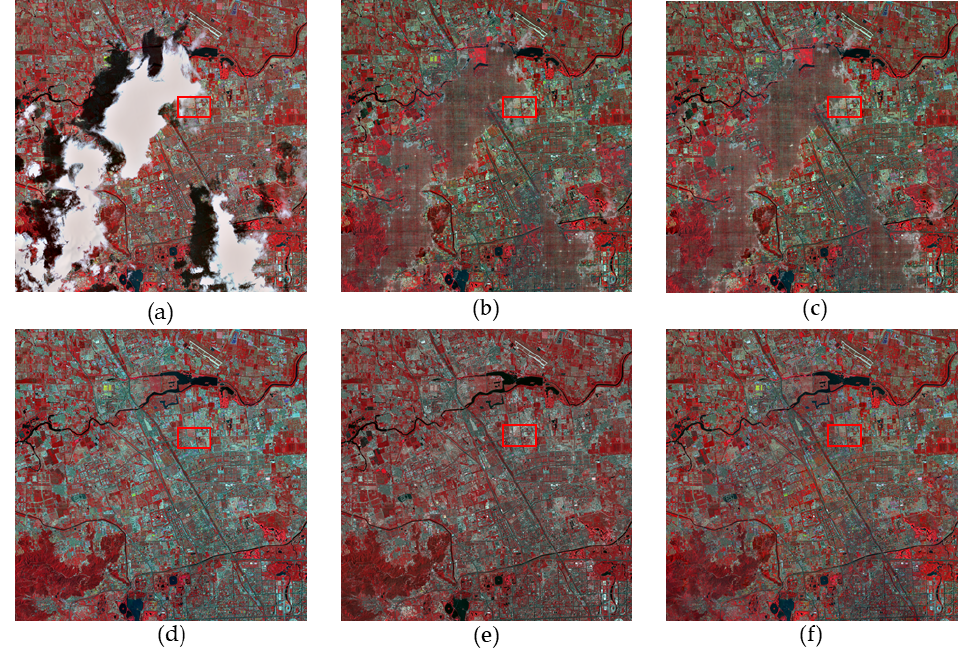
Figure 18. SPOT-5 images for the third real-data experiment: ( a ) cloud image; ( b )–( f ) the results of FaLRTC, HaLRTC, TRPCA, TVLRSDC, and TSSTO, respectively.